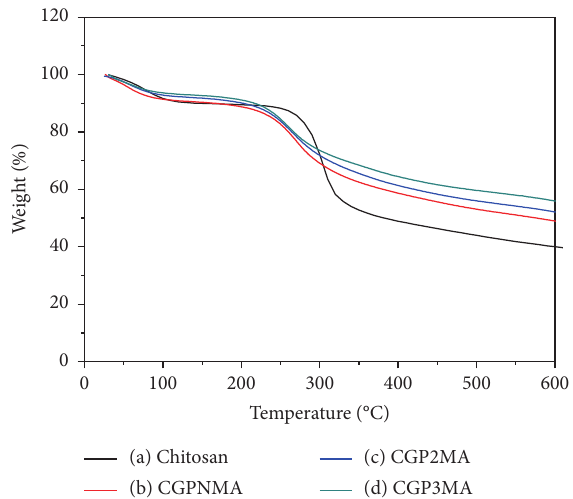
Figure 5: TGA of (a) Chitosan, (b) CGPNMA, (c) CGP2MA, and (d) CGP3MA. Table 1: The elemental analysis of Chitosan and CGPMA and the calculated grafting percent.